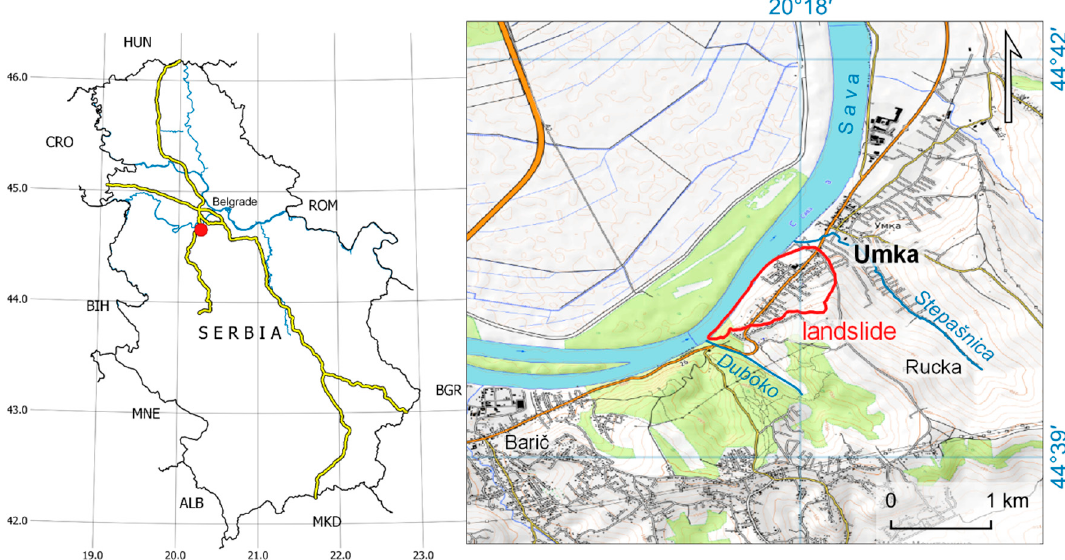
Figure 1. Geographical location of the “Umka” landslide (red dot) within Serbia and major roads ( left ) and its location within the near surrounding outlined in red ( right ).